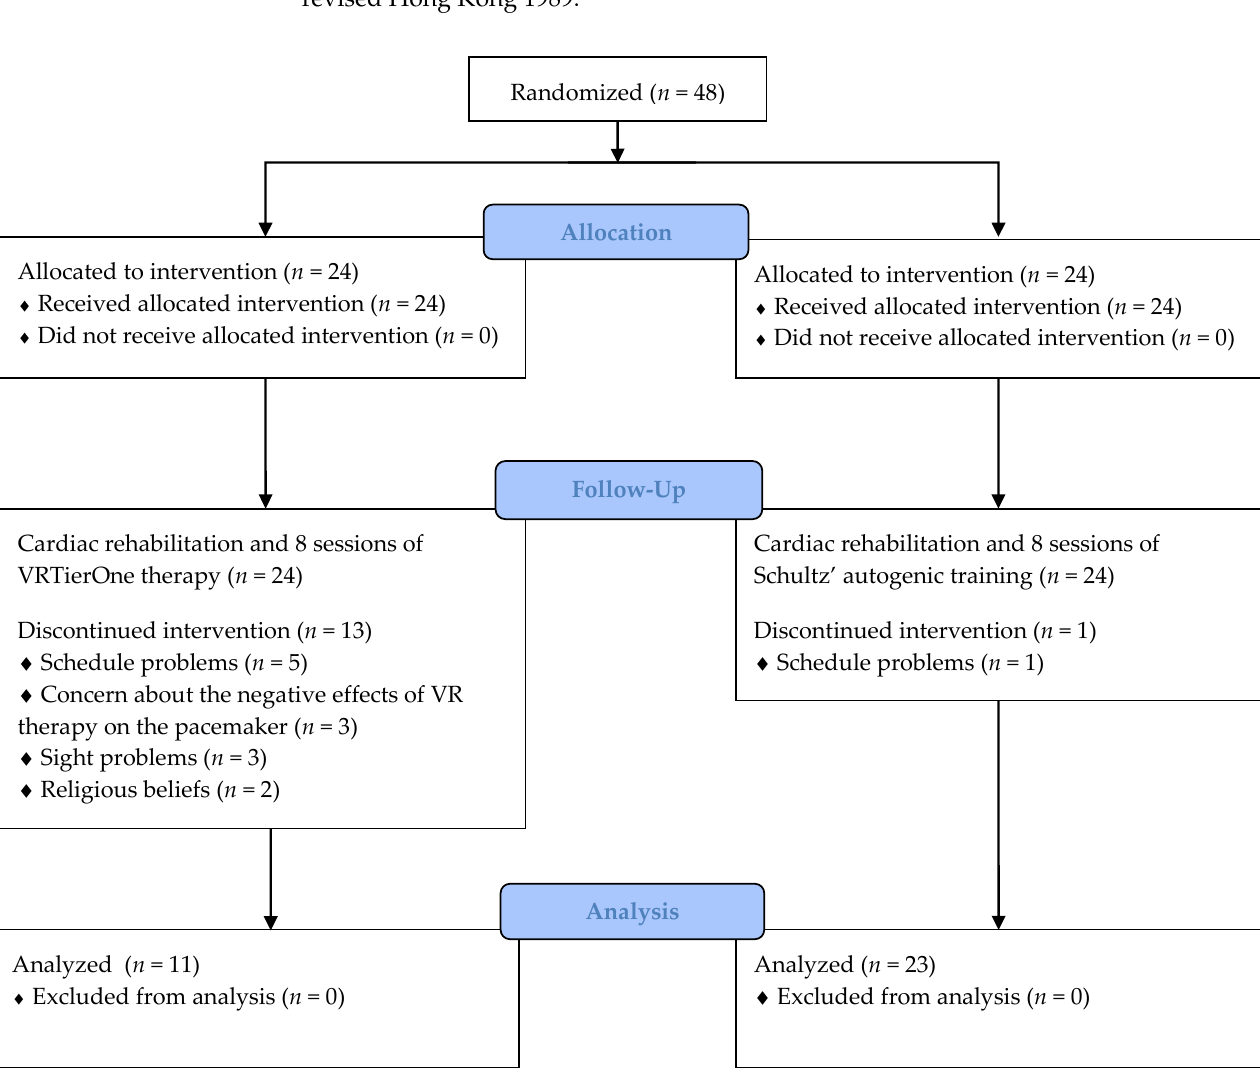
Figure 1. The flow diagram. Figure 1.